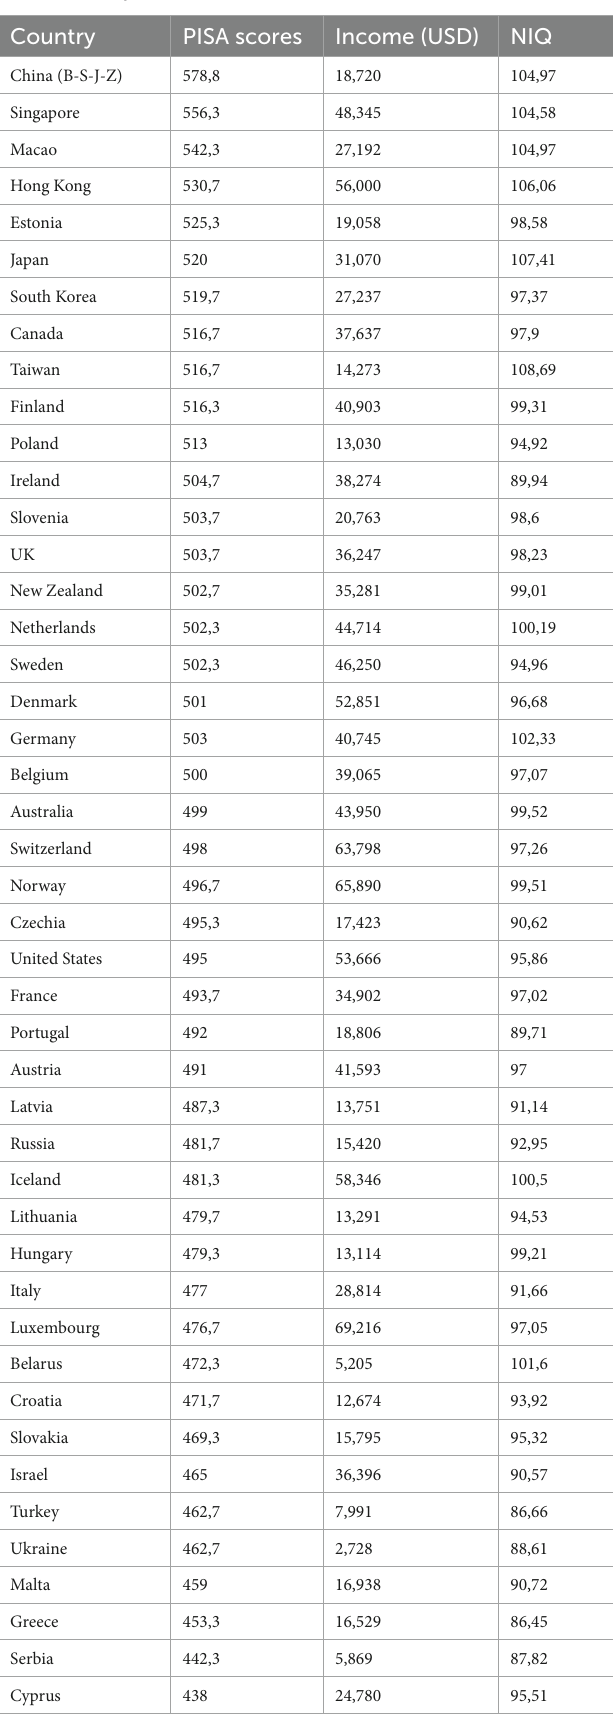
TABLE 1 Descriptive statistics PISA